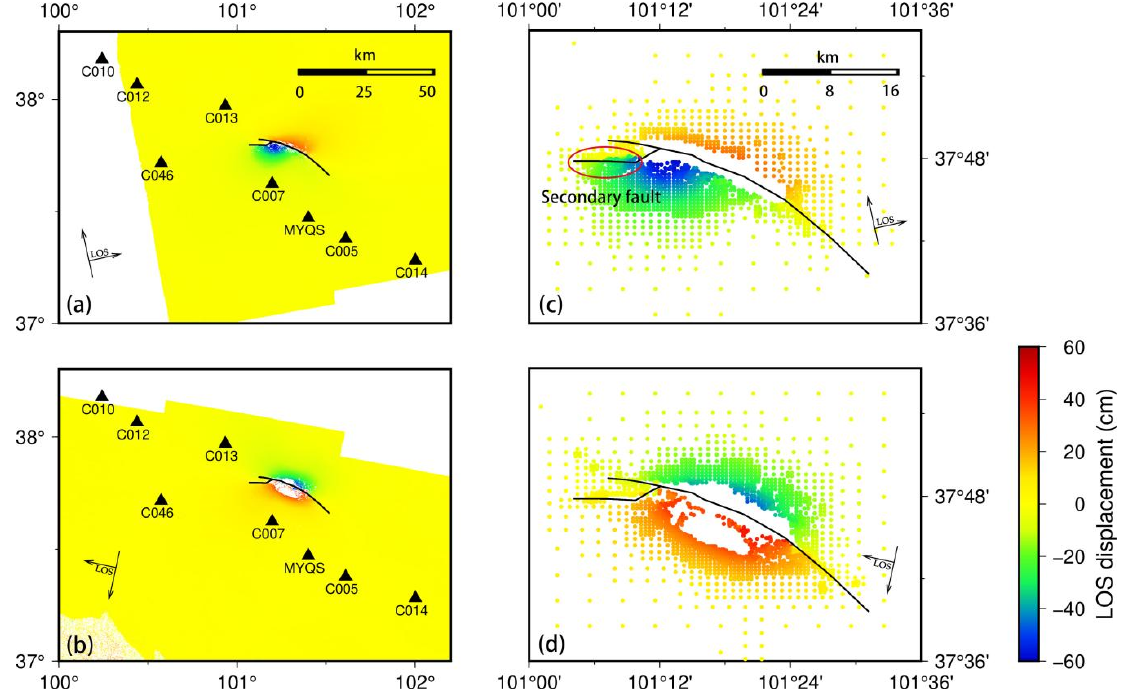
Figure 2. InSAR line-of-sight (LOS) displacement field from ascending ( a ) and descending ( b ) tracks with the distribution of intensity meter (black triangles) shown. InSAR LOS displacement field of ascending ( c ) and descending ( d ) tracks sampled by quadtree. The black lines mark the surface trace of the fault hosing the Menyuan earthquake. Red ellipses mark the fault bifurcation at the western end of the rupture.